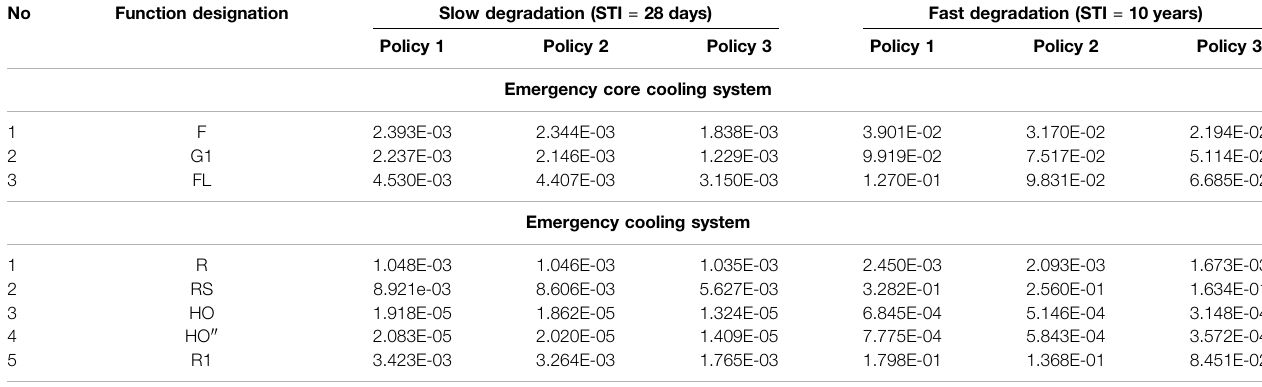
TABLE 8 | Comparison of unavailability calculated by coupling MMMs with FT method between two different degradation rates. No